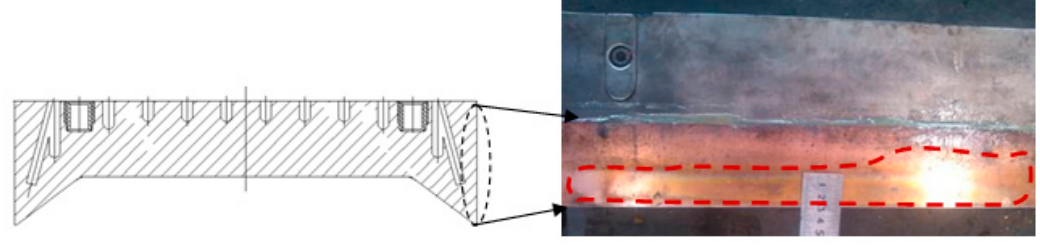
Figure 10. The narrow face of the mold.